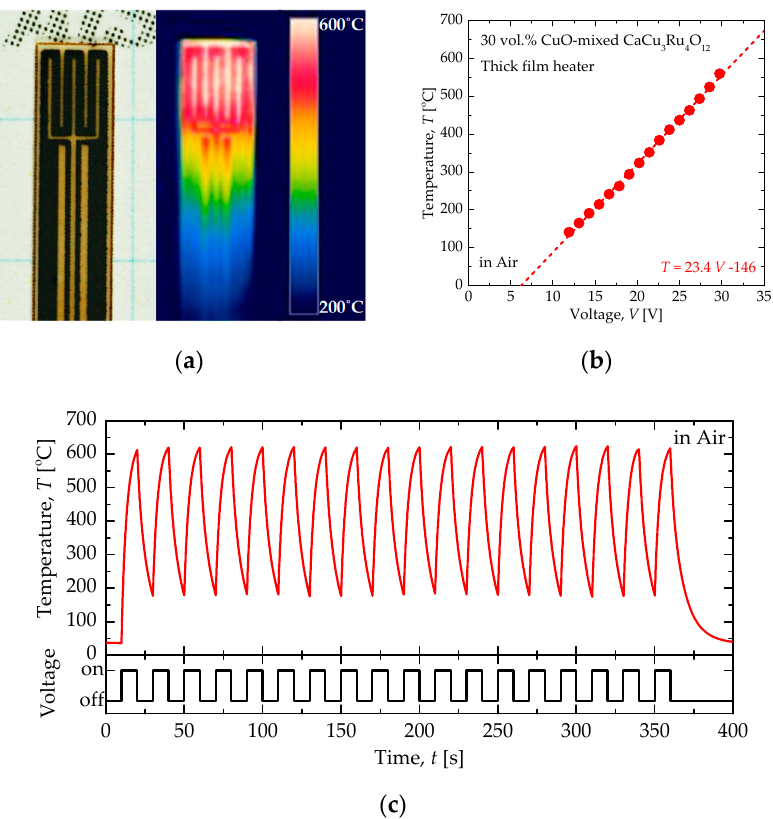
Figure 5. ( a ) Photograph of the 30 vol. % CuO-mixed CaCu 3 Ru 4 O 12 thick-film heater on the alumina substrate and a thermal-camera image with an applied voltage of 32 V DC. ( b ) Temperature ( T ), defined as the maximum temperature over the meandering heater pattern, as a function of the applied voltage. ( c ) Temperature of the heater under cyclic 32.0 V pulses with a width of 10 s and cycle time of 20 s. All experiments were performed in air.